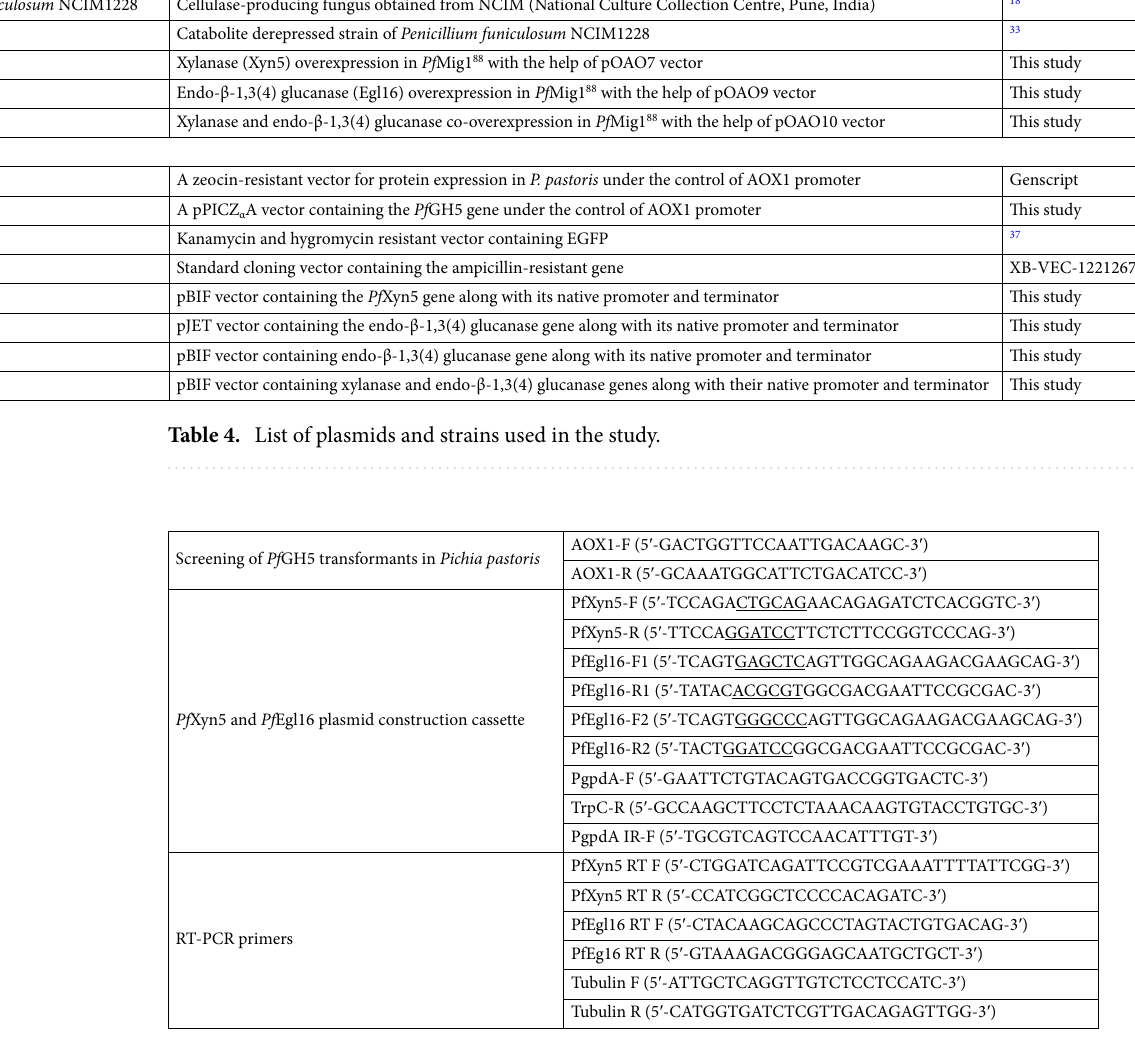
Table 5. List of primers used in the study. The underlines are the site of the restriction enzyme used for cloning.